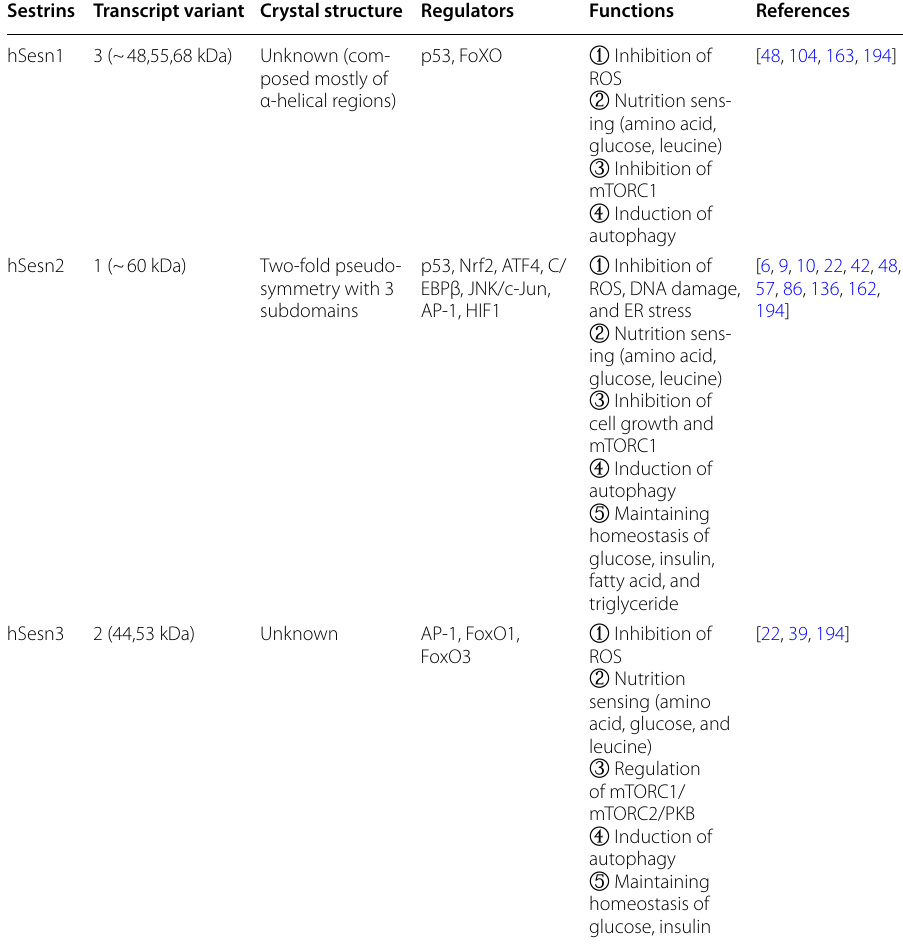
Table 1 Structure and functions of human